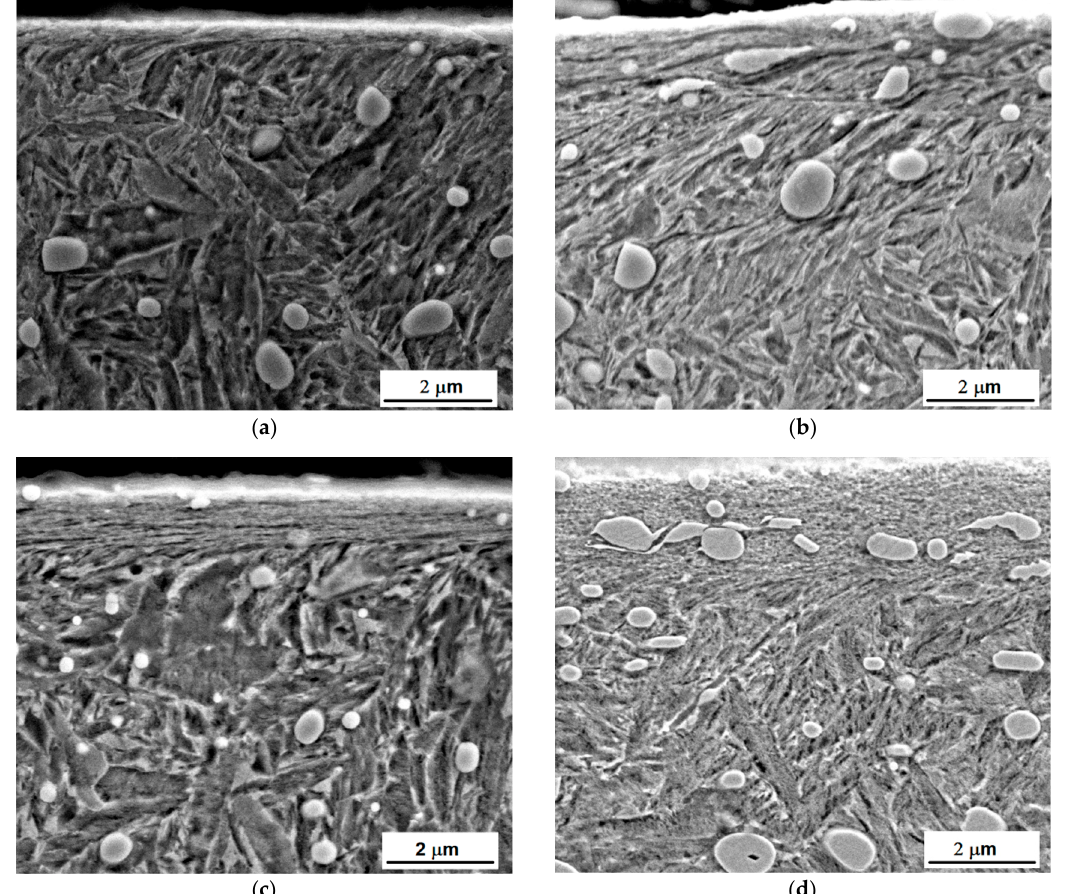
Figure 8. SEM micrographs of milled surfaces: ( a ) VB = 0.05 mm, ( b ) VB = 0.2 mm, ( c ) VB = 0.6 mm, and ( d ) VB = 0.8 mm.